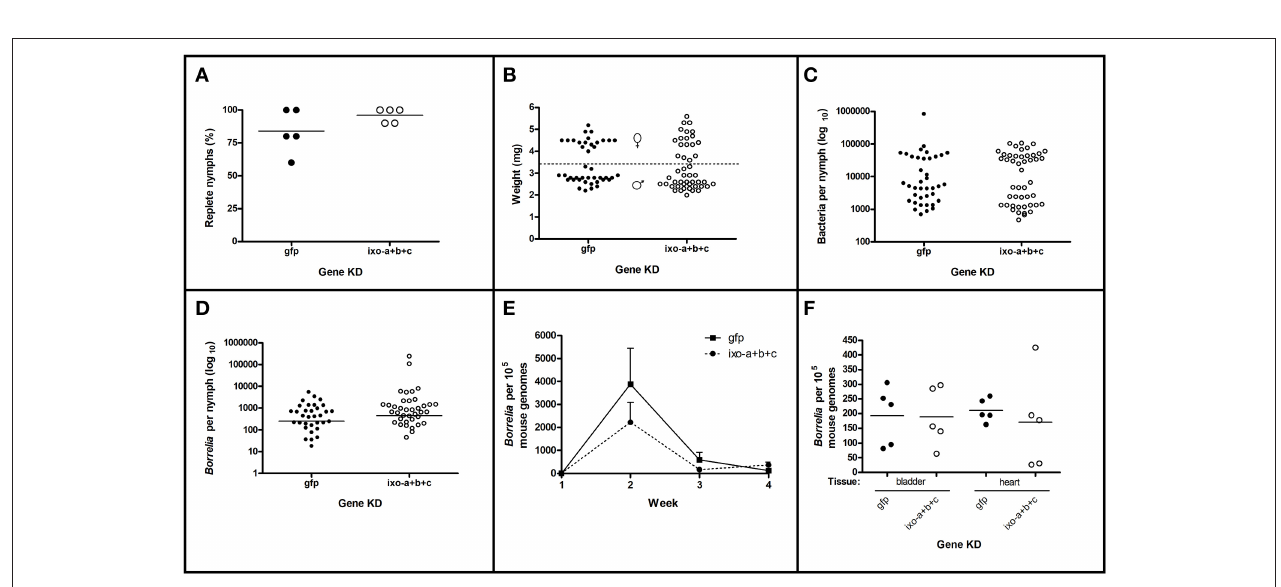
FIGURE 8 | Silencing of ixoderins does not affect Borrelia transmission. Transmission of B. afzelii CB43 from naturally infected nymphs to mice was tested after ixoderins triple KD. Five mice were infested with 10 nymphs each in individual groups. (A) Percent of nymphs replete from each mouse. (B) Weights of individual replete nymphs. Dashed line indicates suggested border between female and male nymphs. (C) Number of bacteria (universal primers) in the individual nymphs measured by qRT-PCR (log 10 scale). (D) Number of Borrelia in the individual nymphs measured by qRT-PCR (log 10 scale). (E) Number of Borrelia in the mice ear biopsies during 4 weeks of infection and (F) number of Borrelia in the destination tissues 4 weeks after infestation measured by qRT-PCR. The number of Borrelia was normalized to 10 5 mouse